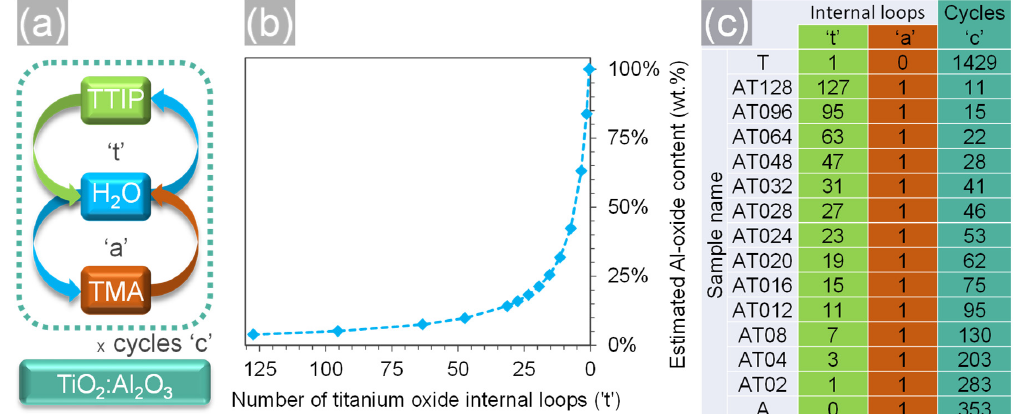
Figure 1. ALD super-cycle processes used to deposit titanium oxide doped with aluminum oxide films. ( a ) Schematic illustration of ALD super-cycles showing the internal loops for titania (‘t’) and alumina (‘a’) as well as the outer loop for the cycling (‘c’). All three define the content of oxides within the film, depicted in ( b ). An overview of all samples produced within this study and their respective super-cycle parameters is shown in (c).